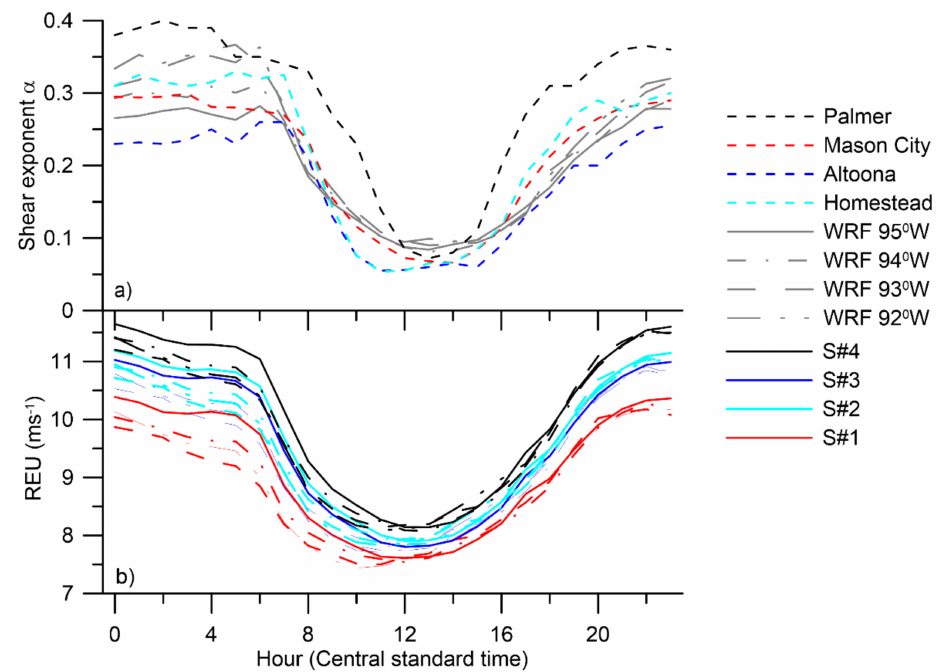
Figure 8. ( a ) Diurnal variability of the shear exponent over the layer from 50–150 m from WRF for the four transect sites and measurements at four sites in Iowa as reported in Reference [23]. ( b ) Diurnal variability of REU based on output from WRF for the four transect locations and four WT